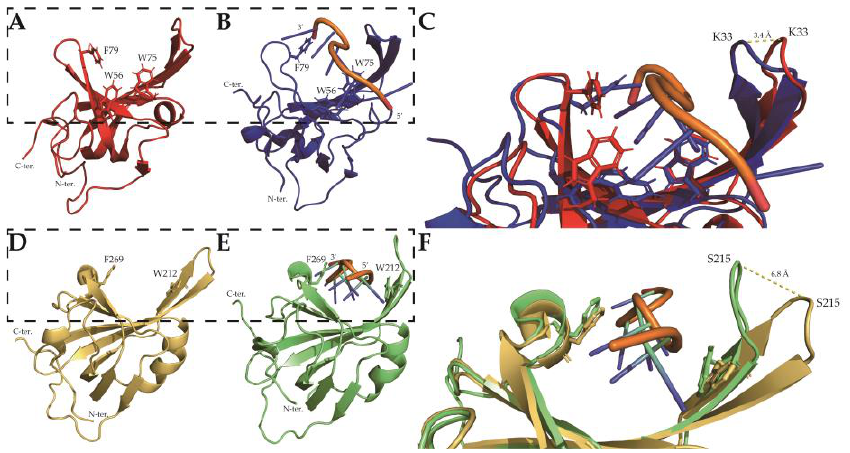
Figure 8. Protein structures of OB-fold proteins apo form and ssDNA bound form. NMR structure of SsoSSB ( A ) apo form (PDB ID: 7WCG; indicated with red) and ( B ) with ssDNA (PDB ID: 2MNA [15]; indicated with blue). ( C ) Zoom of the structure overlapping of ( A ) and ( B ). X-ray structure of hRPA70A ( D ) apo form (PDB ID: 1FGU [46]; indicated with yellow-orange) and ( E ) with ssDNA (PDB ID: 1JMC [47]; indicated with lime). ( F ) Zoom of the structure overlapping of ( D ) and ( E ). Aromatic residues which interact with ssDNA show with sidechain stick structure. The zoomed areas are indicated by a dotted square in each figure.